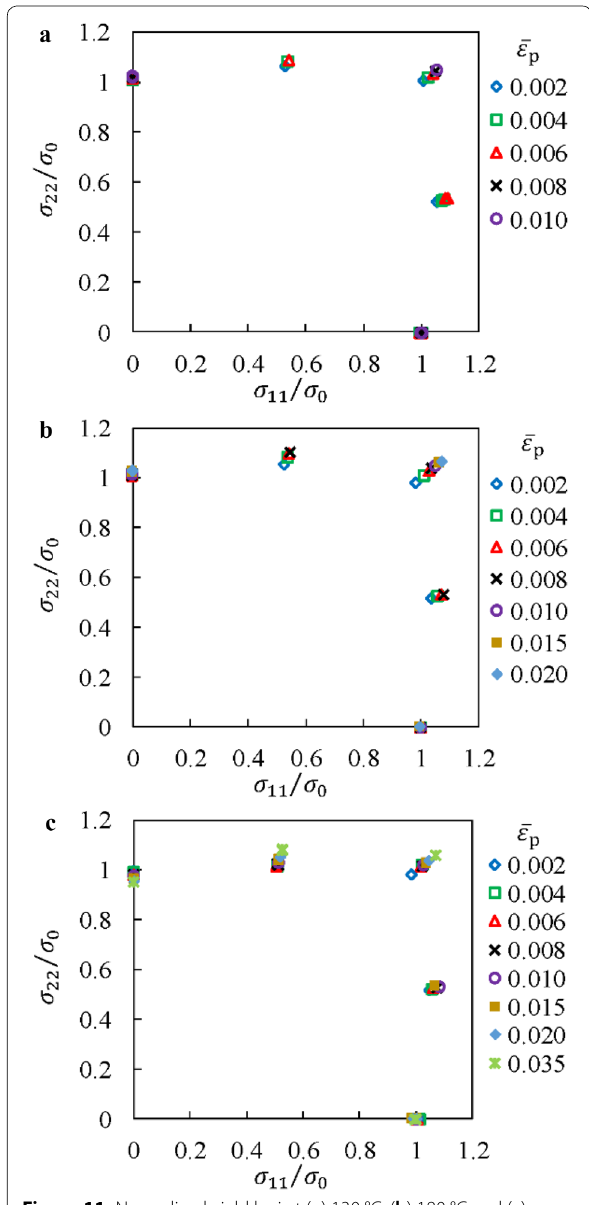
Figure 11 Normalized yield loci at ( a ) 130 °C, ( b ) 180 °C and ( c ) 230 °C as a function of equilvalent plastic